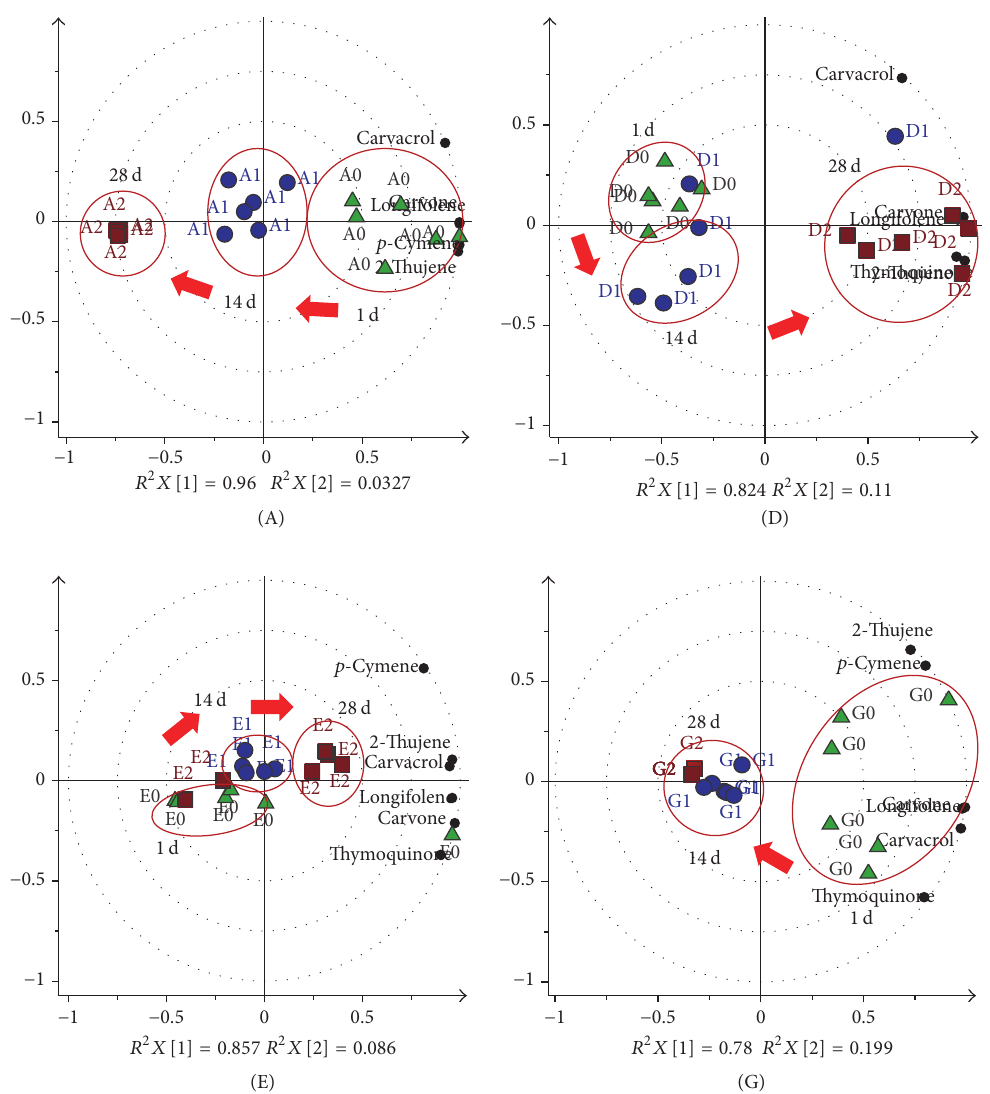
Figure 3: The biplot model of the principle component analysis (PCA) for storage to determine the effects of air; 1st (green triangle), 14th (blue circle), and 28th (red square) day. The smaller black circles are those identified compounds from the